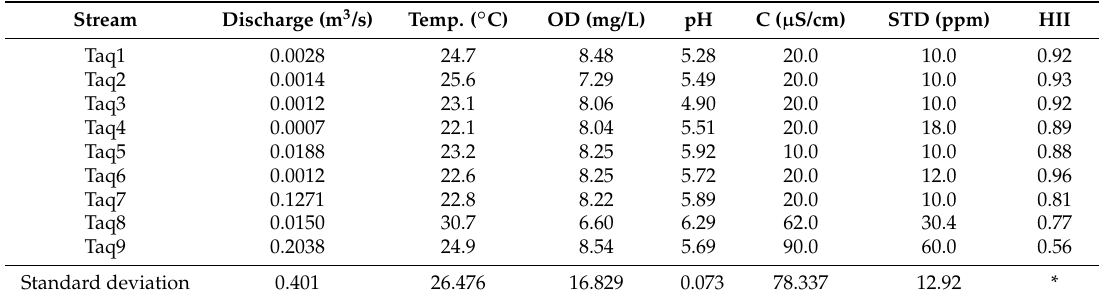
Table 2. Physical and chemical characterization of nine streams in the Taquaruçu Grande river basin, State of Tocantins, Brazil. HII, Index of Habitat Integrity. OD = Dissolved Oxygen. STD = Total Dissolved Solids. Stream